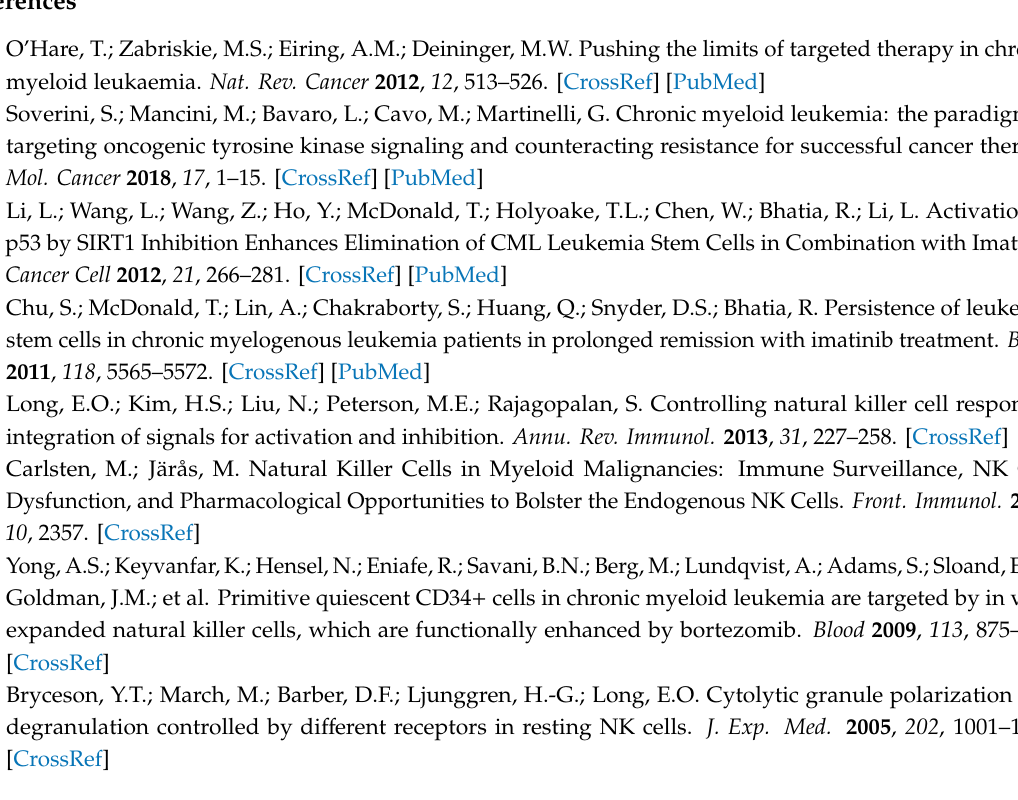
Figure S1: Molecular characterization of BCR-ABL1 T315I mutation in KCL-22M cells, Figure S2: Reduced susceptibility of K562 cells harboring a wild-type BCR-ABL1 to NK cells after IM treatment, Figure S3: Association of primary CML-BC cell cytolysis with NK cell cytolytic activity, Figure S4: FACS gating strategy, Table S1: Characteristics of study